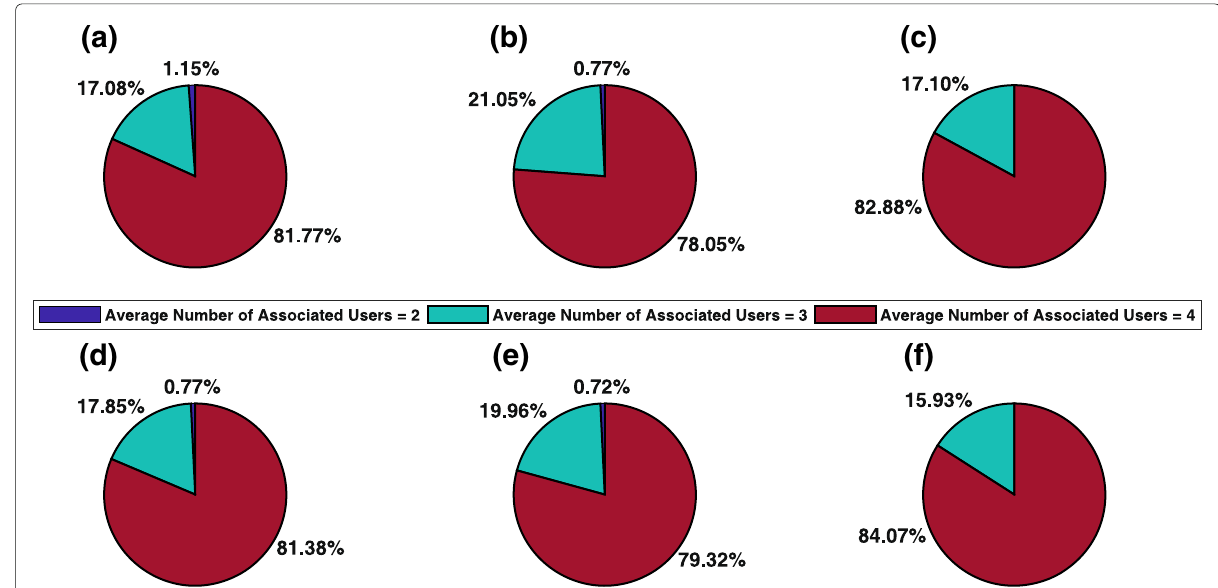
Fig. 7 Average number of associated users— SP-PF-SINR-MAX(BS-SM) algorithm. a BS 1 (Scenario 1). b BS 2 (Scenario 1). c BS 3 (Scenario 1). d BS 1 (Scenario 2). e BS 2 (Scenario 2). f BS 3 (Scenario